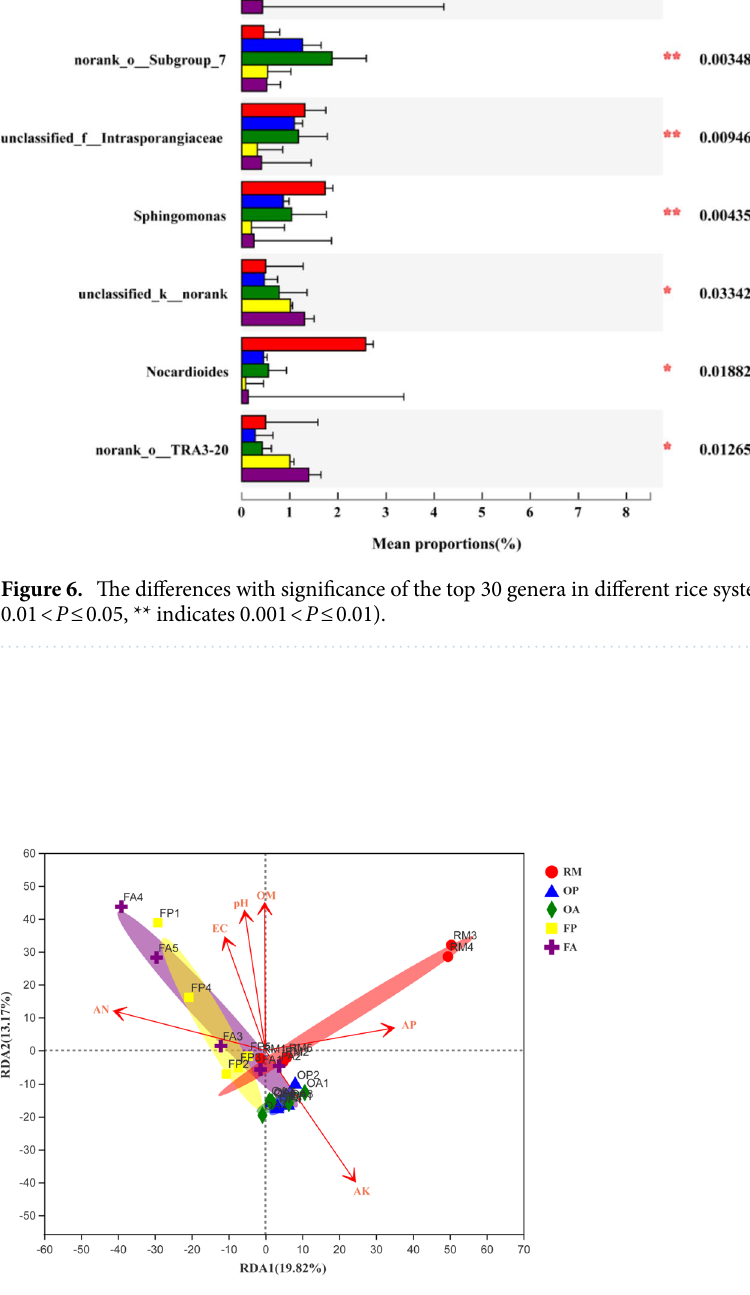
Figure 7. RDA analysis at the OTU level between the soil bacterial communities and soil